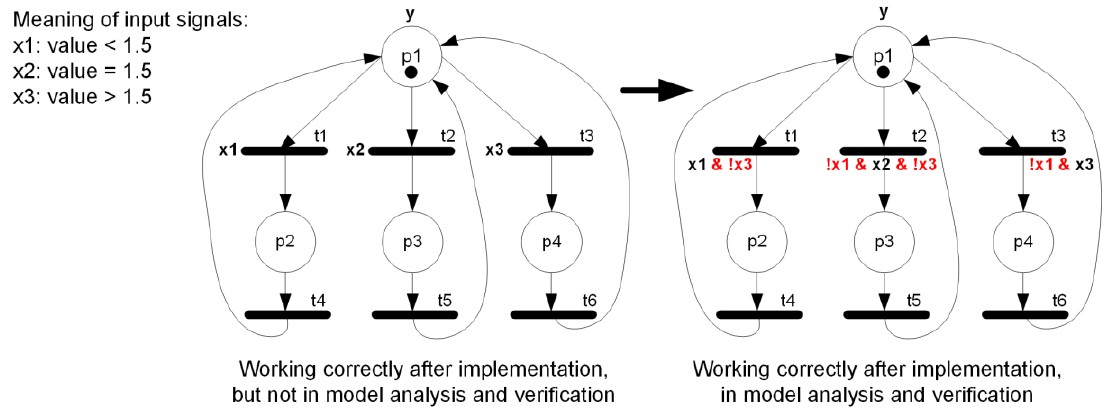
Figure 3. Interpreted Petri net for rule-based logical model.